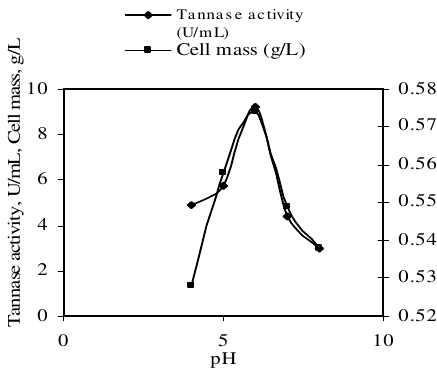
Figure 2. Effect of initial pH on tannase production.